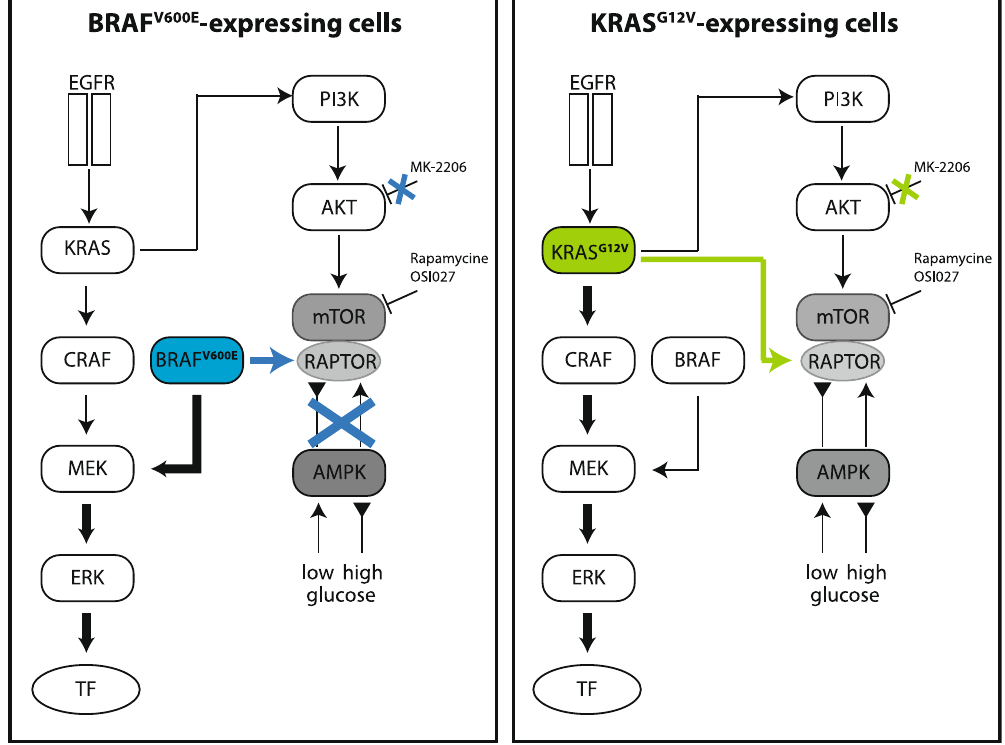
Figure 7. Signaling towards mTOR differs in cells expressing KRAS G12V and BRAF V600E . Mitogenic signaling via EGFR did not differ in cells expressing BRAF V600E and KRAS G12V . Cells expressing BRAF V600E showed a disruption of AMPK/mTOR signaling leading to inhibitor resistance. In cells expressing KRAS G12V , AKT/mTOR signaling is disrupted resulting in inhibitor resistance; however signaling via AMPK is